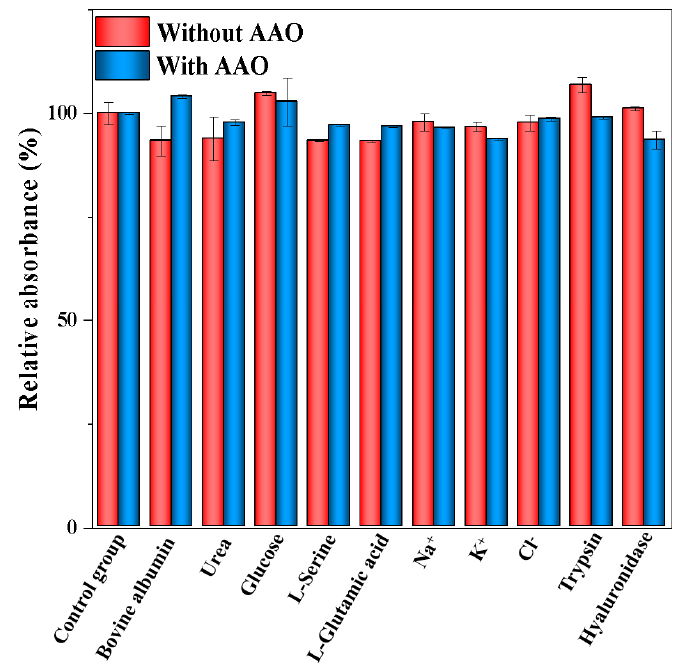
Figure 6. Selectivity and interference study of the colorimetric assay for AAO activity detection. Error bars represent standard deviations ( n = 3).